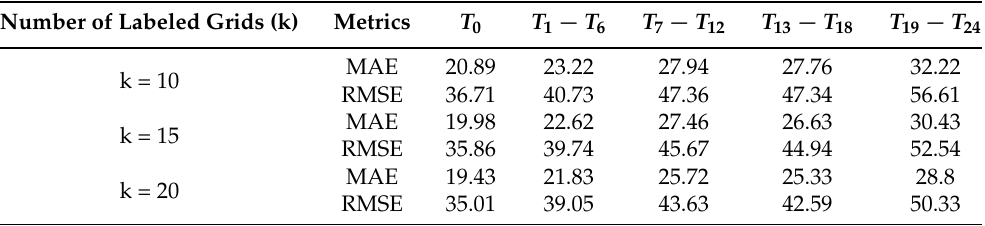
Table 7. Comparison results for our proposed model with the different number k of labeled grids. The values in the table are the MAE and RMSE of AQI